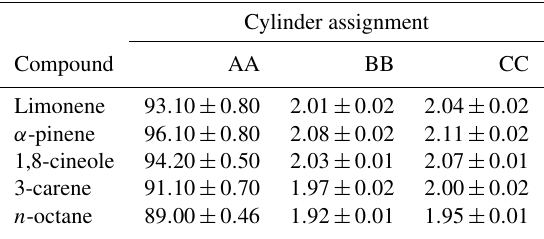
Table 1. Gravimetric compositions of monoterpene PRMs made by dilution of the parent mixtures (mixtures A–E). Amount fractions are all in nmolmol − 1 , uncertainties in the gravimetric preparation are expanded ( k = 2) and do not include uncertainties arising from the experimental